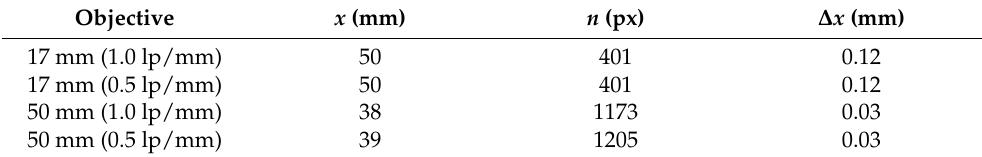
Table 1. Spatial calibration of custom-made laboratory HSI system. Distance on the Ronchi grid x that spans n pixels for each objective lens gives the size of the pixel ∆ x on the image plane. Calibration is performed for 2 × binning along the spatial